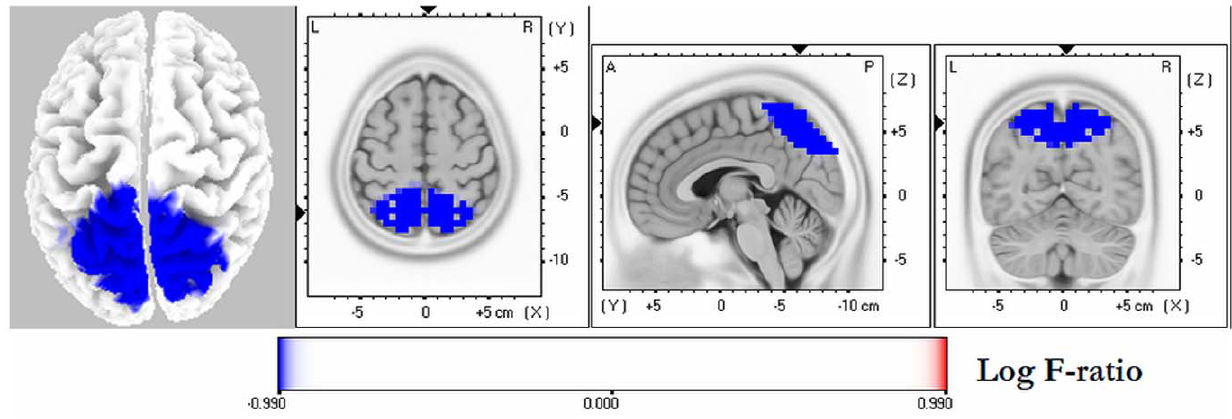
Figure 2. eLORETA statistical maps of alpha1 oscillations in patients with Alzheimer’s disease vs. controls. Colored areas represent the spatial extent of voxels with significant difference in source current density (p , 0.05, corrected). The MRI slices are located at the MNI-space coordinates of the voxel with highest significance. The color scale represents log F-ratio values (threshold: log F= 2 0.99, p , 0.05). L, left; R, right; A, anterior; P, posterior.